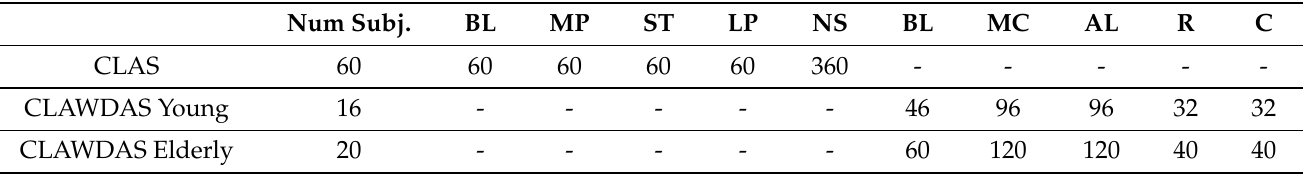
Table 1. Number of instances for each task in the CLAS dataset (first 5 columns) and in the CLAWDAS dataset (last 5 columns), distinguished into CLAWDAS Young and CLAWDAS Elderly. BL = Baseline, Calculation, R = Reading, C =